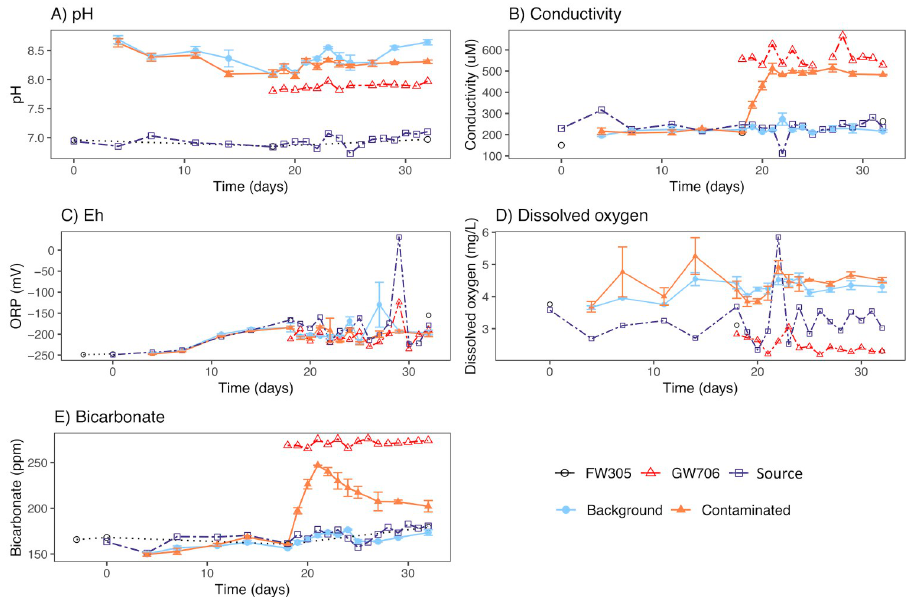
Fig 1. Physicochemical measurements from unfiltered water sampled from bioreactors receiving background or contaminated water, groundwater from wells FW305 and GW706, and the source reservoir for the background reactors over the duration of experiment. Error bars represent one standard error. Data are presented as average ± standard deviation for 3 water samples from FW-305 collected on days 0, 18, and 32, and from 8 replicate water samples collected from GW-706 on day 15. In-well temperature for FW-305 represents one measurement taken prior to the start of the